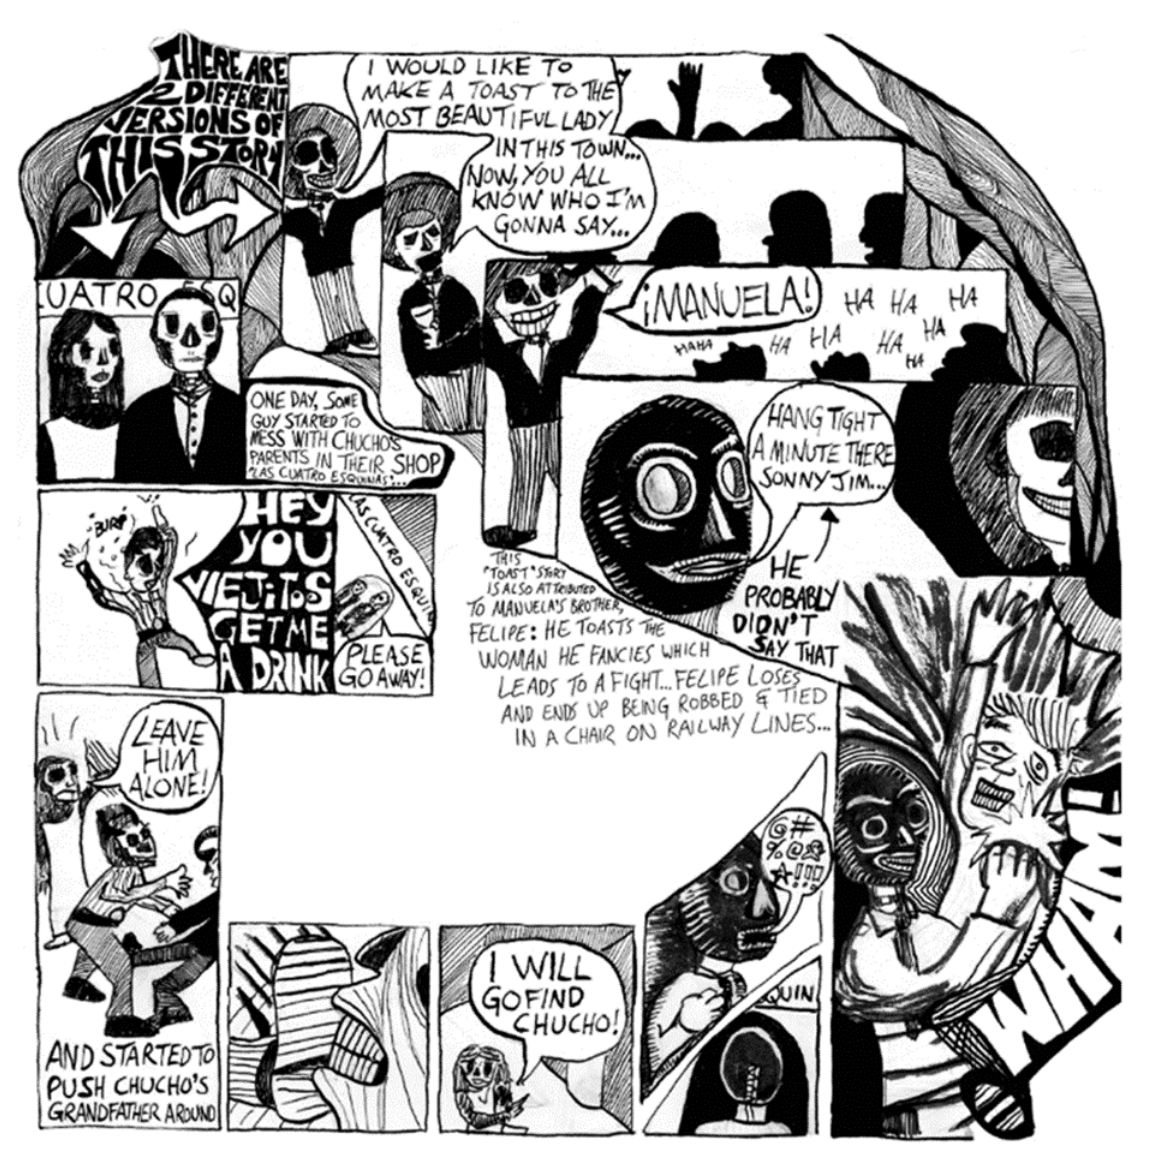
Figure 6: An illustration of teléfono descompuesto in action as featured in the multimodal piece for Trajectoria (Sherwood González 2022). It conveys the multiplicity of stories about when Chucho punched the son of ‘the second most important man’ in Irapua to,